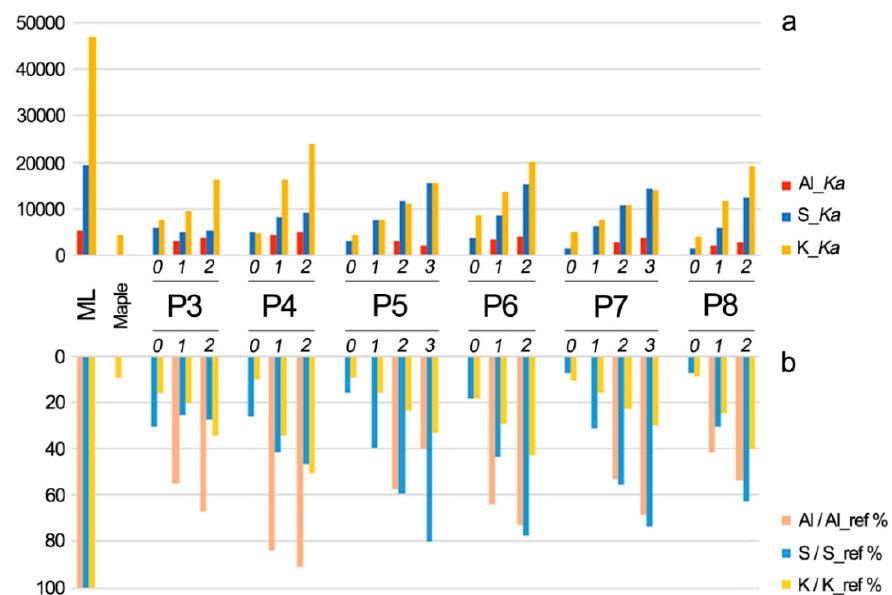
Figure 6. ( a ) Rough estimates of Al, S ad K signals expressed as the area under the Ka peaks; ( b ) elemental percentage of the mock-ups area values with respect to the area values detected from a pellet of pure ML.